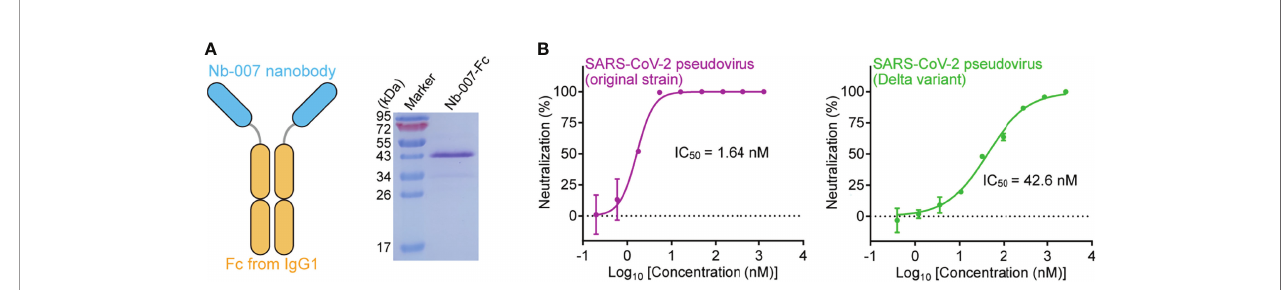
FIGURE 6 | Improvement of the neutralizing activity of Nb-007 by fusion with Fc. (A) Diagram (left panel) showing the bivalency of Nb-007 by fusion with the Fc domain of human IgG1. The SDS-PAGE analysis of the puri fi ed Nb-007-Fc protein is shown in the right panel. (B) Neutralization of SARS-CoV-2 pseudovirus by Nb- 007-Fc. Left panel: Nb-007-Fc against the pseudovirus of the original SARS-CoV-2 strain. Right panel: Nb-007-Fc against pseudovirus of the Delta variant. Each error bar shows the mean ± SD. Experiments were performed in